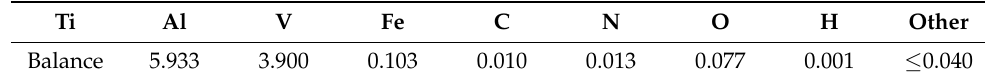
Table 2. Chemical composition of Ti6Al4V titanium alloy, [%].